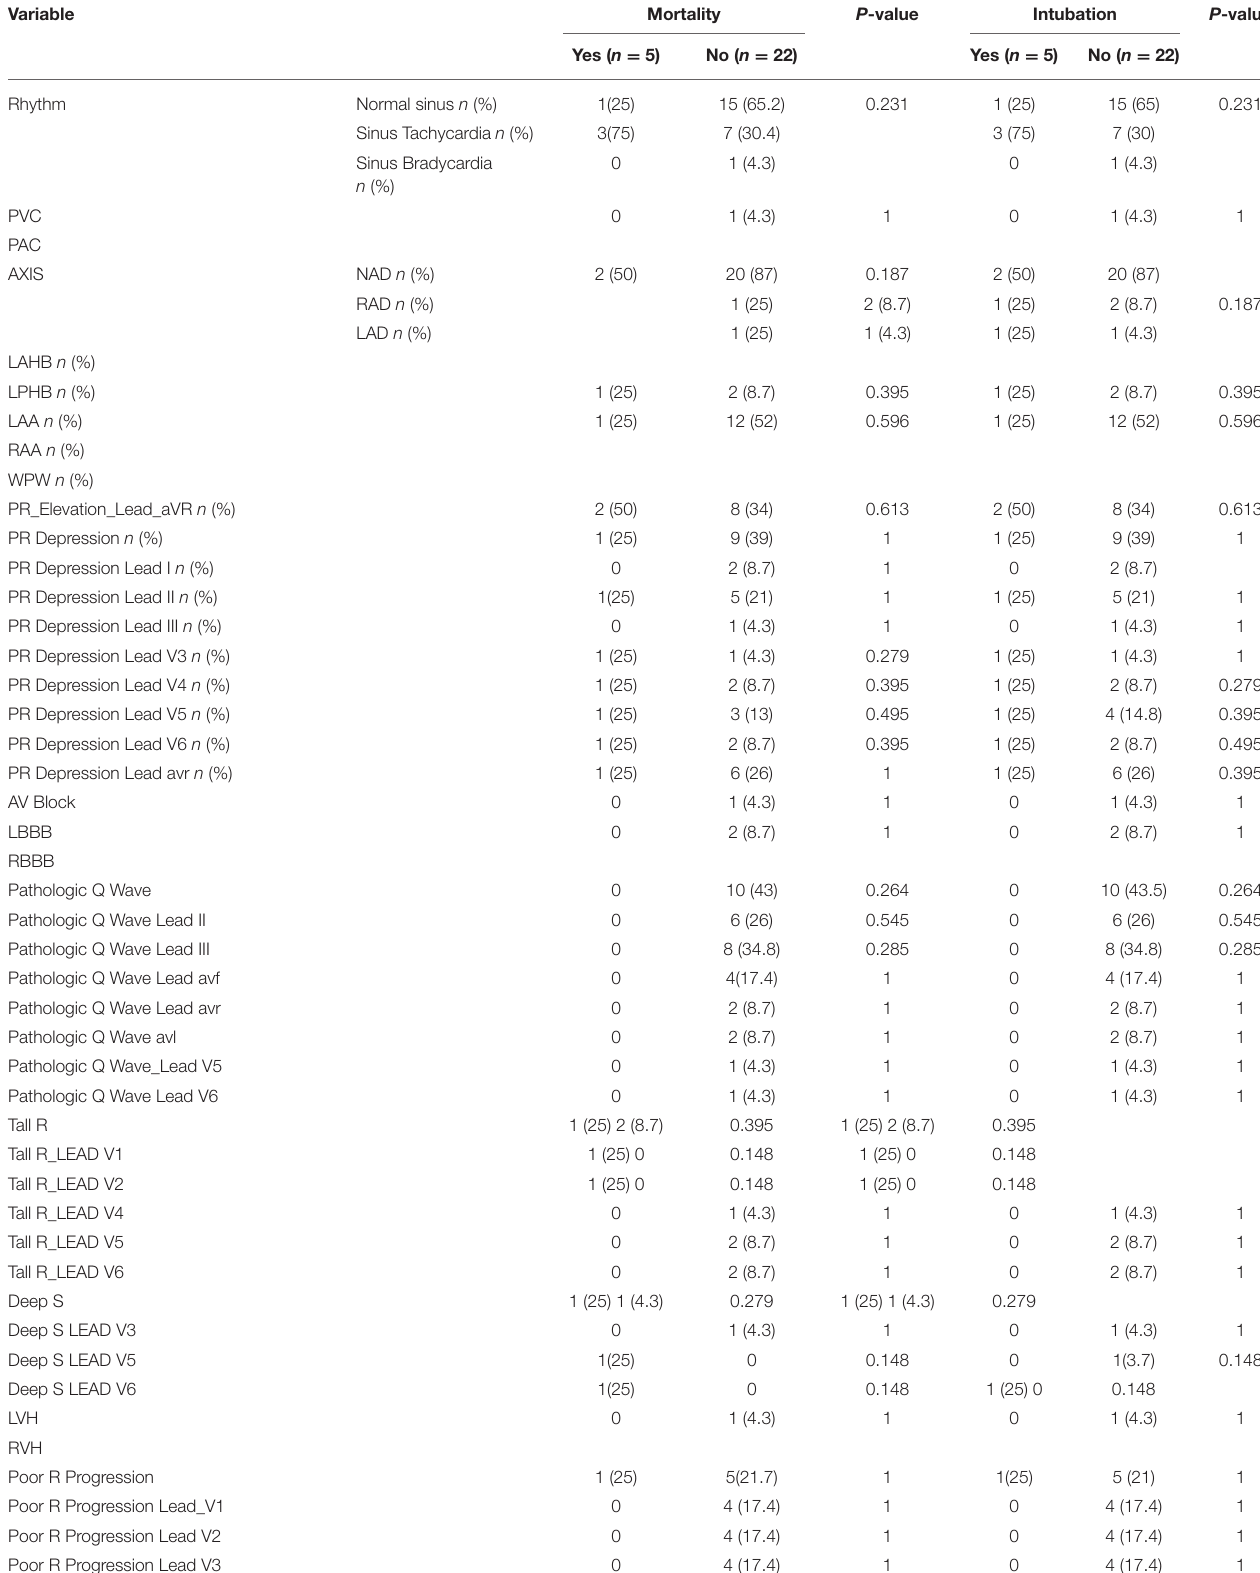
TABLE 5 | Qualitative ECG findings in mortality and intubation groups. Variable